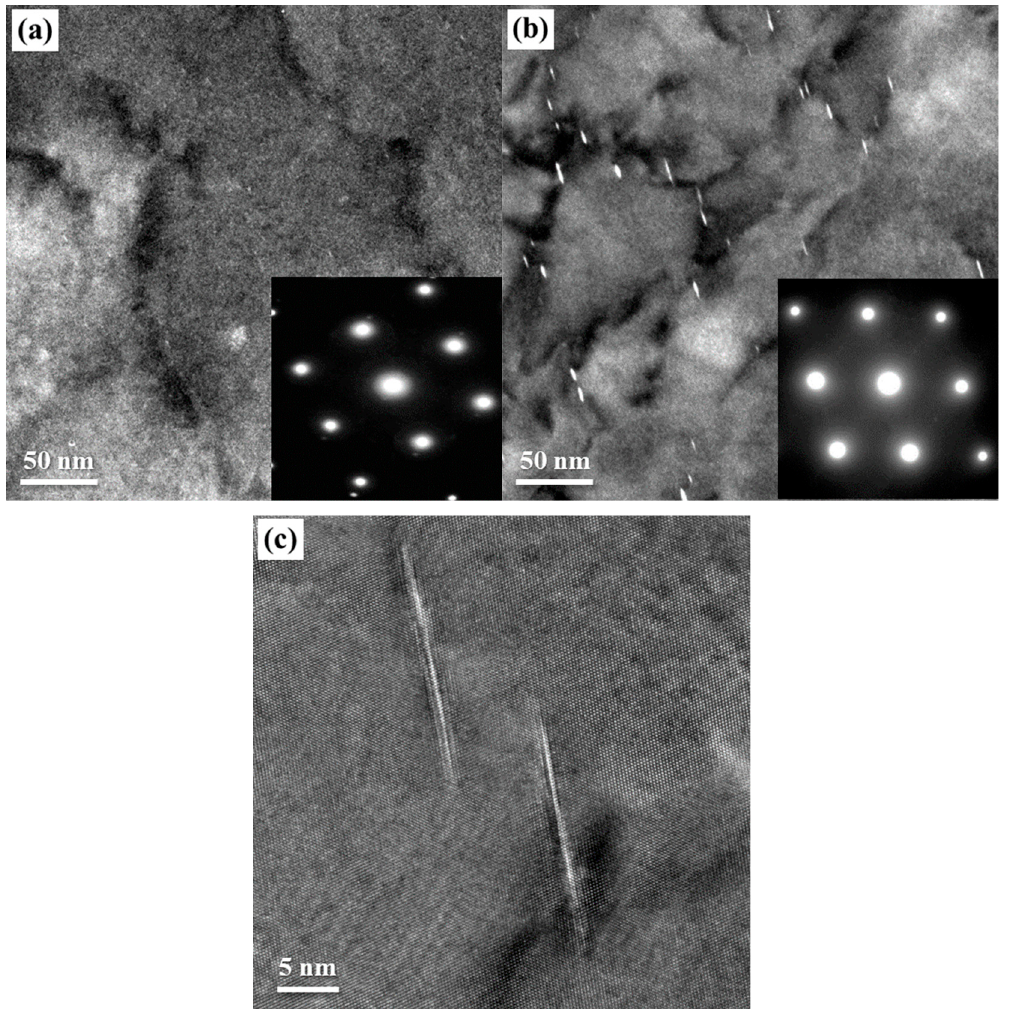
Figure 8. TEM images and SAED spots along [110] Al zone axis of AA2195 specimens after creep aging for 2 h: ( a ) non-pre-stretching; ( b ) pre-stretching 2%; and ( c ) pre-stretching 2% (HRTEM).